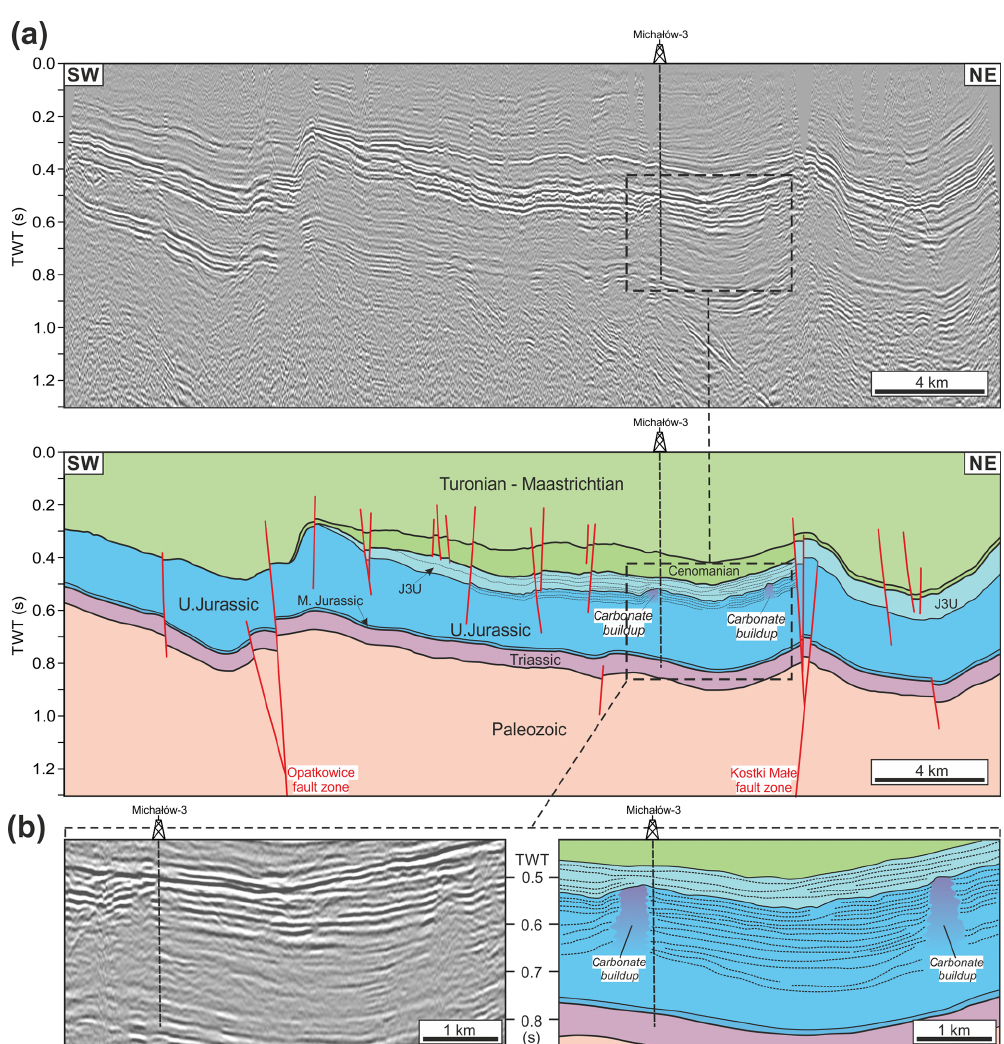
Figure 10. (a) Uninterpreted and interpreted seismic profile (10-5-92K) from the Miechów Trough (see Fig. 5 for location). Major NW– SE-oriented Opatkowice and Kostki Małe fault zones are rooted in the Palaeozoic basement and are associated with inversion anticlines developed within the Mesozoic cover. (b) Two carbonate buildups were identified in this